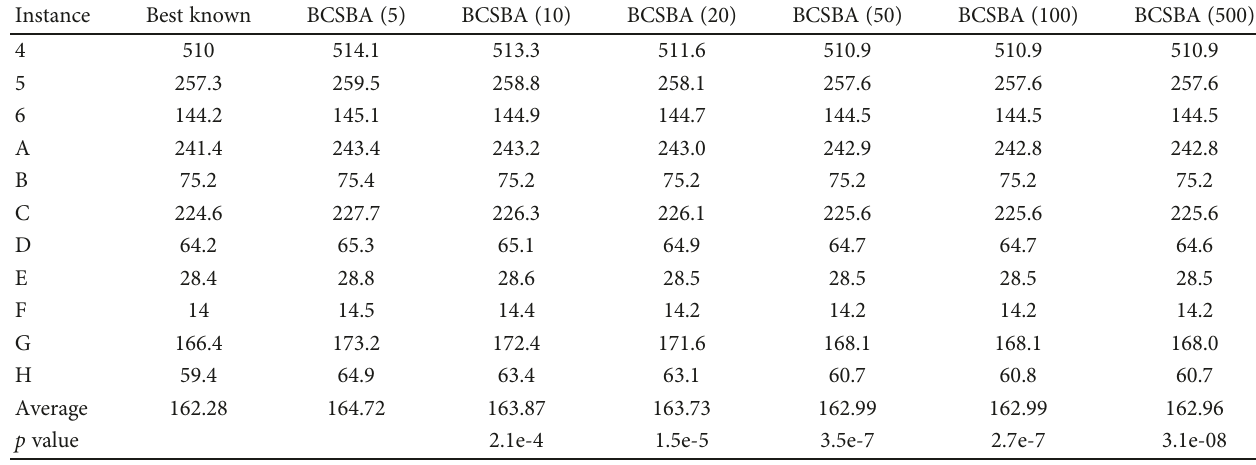
Table 3: Average result by problem type of dataset OR-Library.